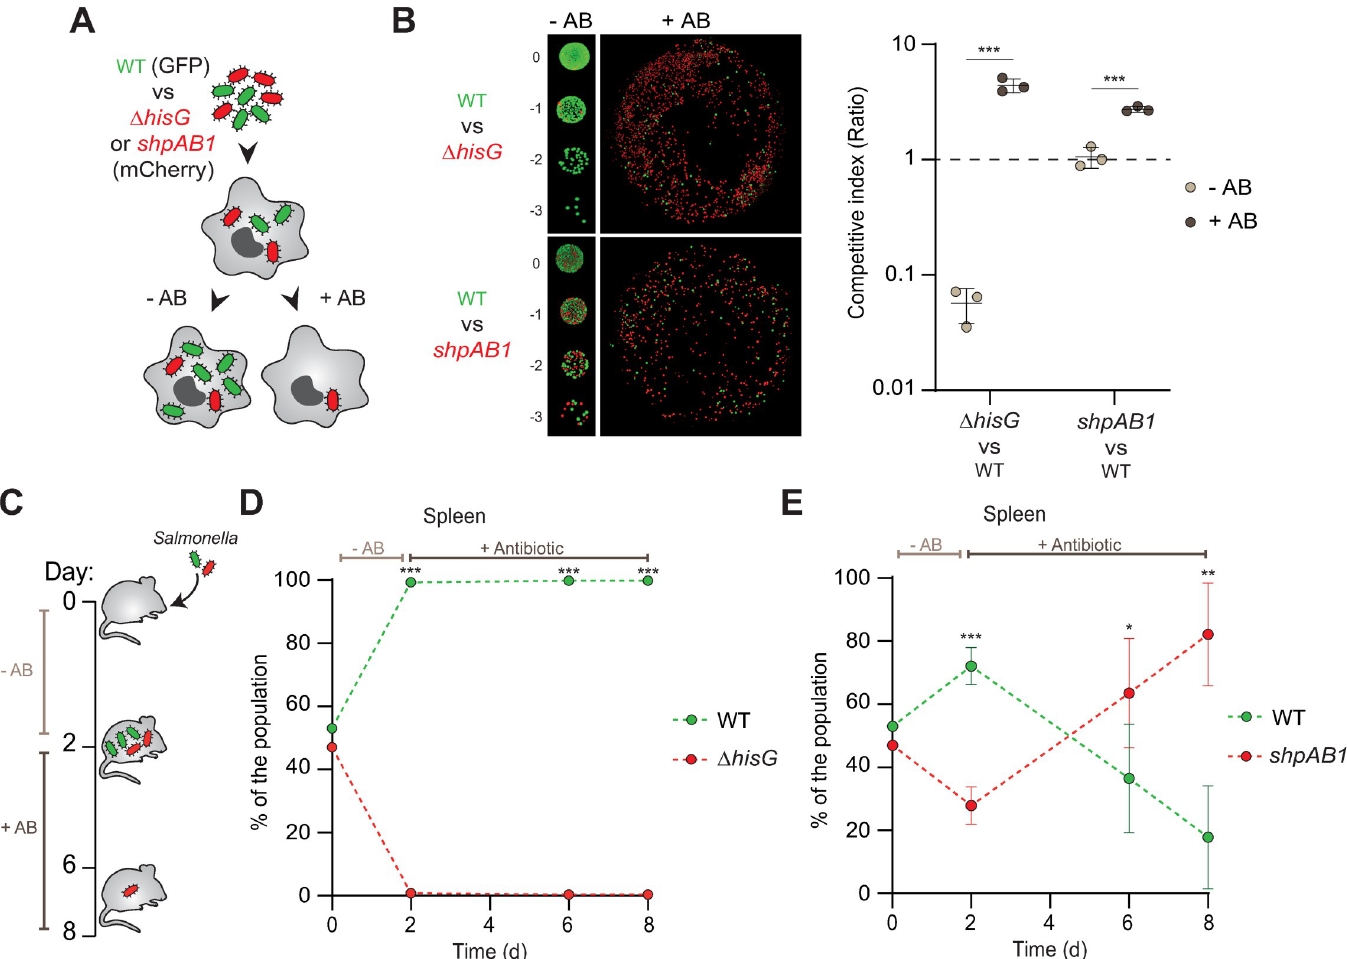
Fig 5. Persistence is a more balanced strategy than tolerance. ( A ) Illustration of the in cellulo competition assay where BMDMs were co-infected with the WT/ shpAB1 or WT/ Δ hisG pair and treated with cefotaxime to assess antibiotic survival (+AB) or gentamicin to assess proliferation (-AB). WT expressed GFP constitutively whereas the shpAB1 and Δ hisG mutants expressed mCherry. ( B ) Left panel, representative images of the bacterial population after extraction of 24 h gentamicin (-AB) or cefotaxime (+AB) treated BMDM. For the proliferation competitive assay (-AB), ten-fold dilution series were spotted on rich medium plate. For the antibiotic survival competitive assay (+AB), the entire bacterial population was plated on rich medium. Right panel, competitive index ratios. Data represent the mean and SD of at least three biological repeats. Statistically significant differences of each pair by two-sided t -test are indicated as ��� p < 0.001. ( C ) Illustration of the in vivo mice co-infection assay with the WT/ shpAB1 or WT/ Δ hisG pair used on panel A and B. Two days after oral gavage, mice were either sacrificed or treated with cefotaxime for 4 or 6 days. ( D-E ) Bacterial survival in the spleen of the WT/ Δ hisG ( D ) and WT / shpAB1 ( E ) mix. Results are expressed in percentage of the total population recovered on plate. Day 0 indicates the inoculum ratio. Statistical significant differences at each timepoint by two-sided t -test are indicated as � p < 0.05 and ��� p < 0.001. In vivo mice experiments were carried out with at least 4 animals per time